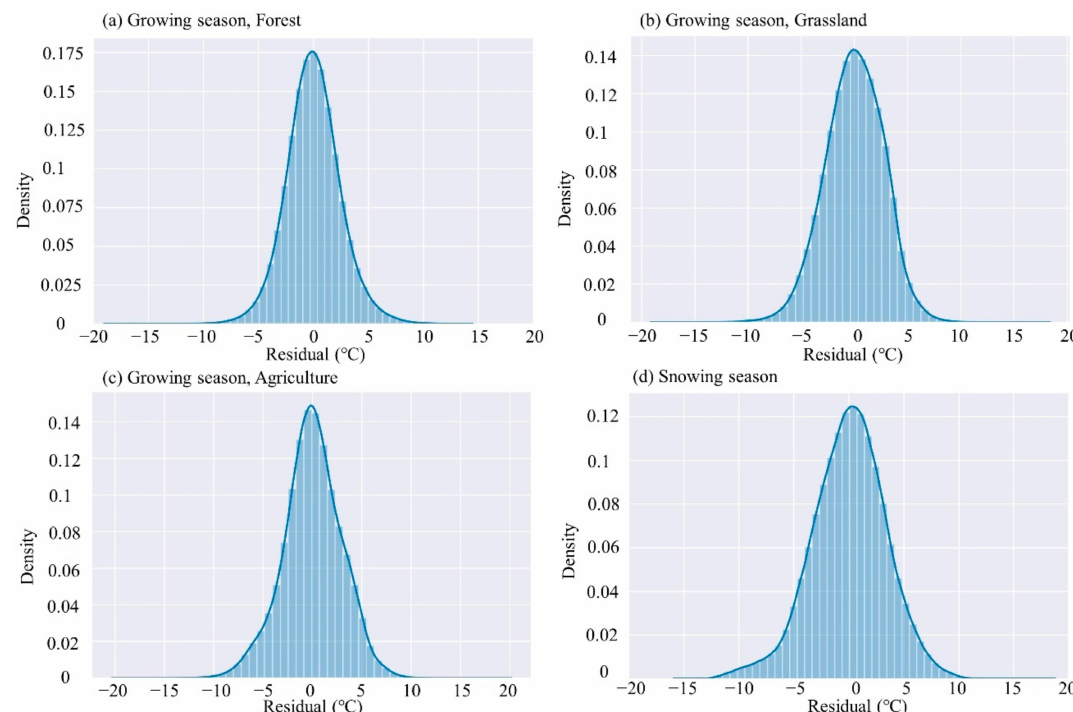
Figure 8. Histograms of the residuals from GAM analysis for three land cover types in the growing season: forest ( a ), grassland ( b ), agriculture ( c ), and all training samples in the snowing season ( d ).